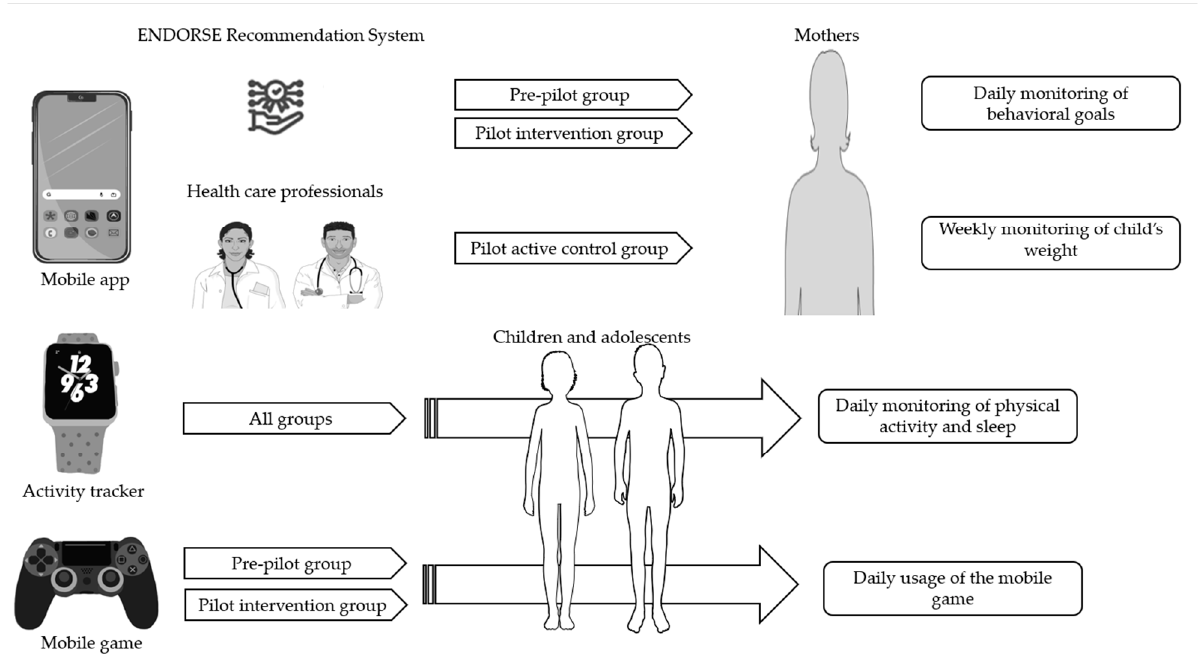
Figure 1. The components of the ENDORSE project consisted of mobile applications directed at both parents and health professionals and aimed to support self-monitoring by mothers. The ENDORSE Recommendation System generated personalized messages to mothers participating in the pre-pilot and pilot intervention groups, while in the pilot active control group, weekly personalized messages were sent by the healthcare professionals to mothers. Activity trackers were provided to all partici- pating children to monitor physical activity and sleep, and an educational mobile game was pro- vided to children participating in the pre-pilot and pilot intervention groups [35]. Parts of the fi gure were drawn using pictures from Servier Medical Art (smart.servier.com), provided by Servier, li- censed under a Creative Commons A tt ribution 3.0 unported license (accessed on 10 March 2023) and fl aticon.com (accessed on 10 March 2023). Subjects were recruited from the Obesity outpatient Clinic of the First Department of Pediatrics of the Medical School of the National and Kapodistrian University, at the ‘Aghia Sophia’ Children’s Hospital in Athens, Greece, and were mostly residents of urban set- tings (i.e., n = 40, 90% residents of Athens). All mothers signed a consent form for them- selves and their child’s participation in the study. The study was approved by the bioeth- ics commi tt ee of ‘Aghia Sophia’ Children’s Hospital (protocol number: 4760, date of ap- proval 10 March 2021). The theoretical framework of the ENDORSE study was self-deter- mination theory (SDT) [36]. The present study focuses only on participants who completed the post-intervention assessment (n = 45, 90% of total participants) of the ENDORSE study. Based on the pri- mary analysis of the ENDORSE study [35], which resulted in signi fi cant changes in BMI z-score, children were categorized into three groups according to BMI z-score change: group 1 with a clinically signi fi cant decrease in BMI z-score ≥ 0.2 according to the US Pre- ventive Services Task Force (n = 21) [9]; group 2 with a decrease in/stable BMI z-score ≥ 0.00–0.20 (n = 16); and group 3 with an increase in BMI z-score > 0.00–0.25 (n = 8). Inclusion/Exclusion Criteria Children aged 6–14 years with a BMI >85th centile, which is the cut-o ff value for the de fi nition of overweight according to the International Obesity Task Force (IOTF), were eligible to participate in the study [37]. Exclusion criteria for participation in the study were secondary causes of obesity, such as endocrine diseases (hypothyroidism, Cushing syndrome, growth hormone de fi ciency), known genetic syndromes linked to obesity